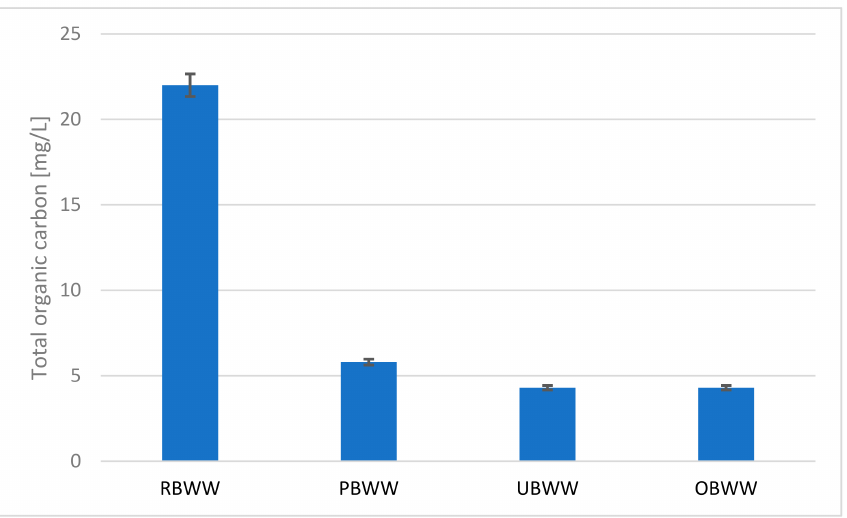
Figure 6. Changes in the TOC content during the treatment process: raw backwash water (RBWW), pre-filter backwash water (PBWW), ultrafiltration backwash water (UBWW), ozonation backwash water